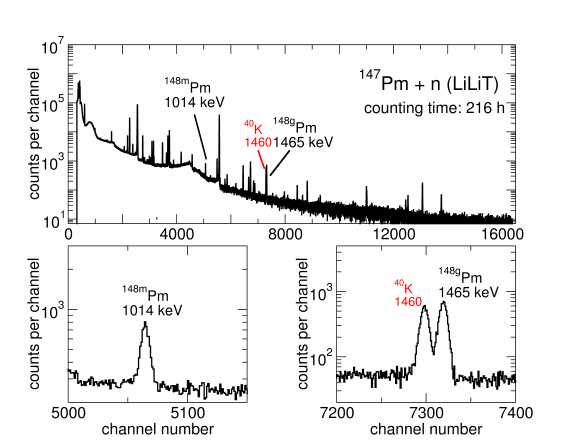
Figure 7. Schematic diagram of the AMS setup at ANL. The 39 Ar 8 + ions from the ECR II ion source are accelerated through the ATLAS accelerator and then analyzed by the Enge gas-filled magnetic spectrograph [25], which physically separates them from beam contaminants with close-by m / q values.